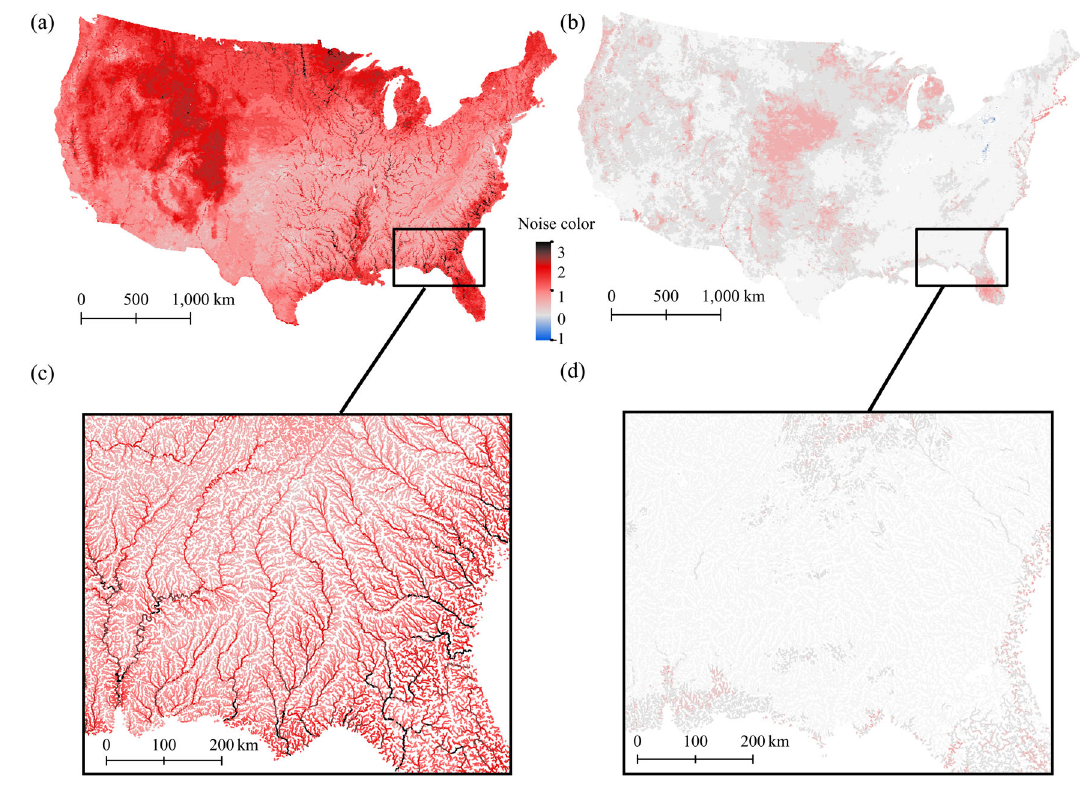
Fig. 4 | Flow noise color predicted by the random forest models at ~430,000 river reaches (~1.9 million km) across U.S. river networks. a Daily fl ow